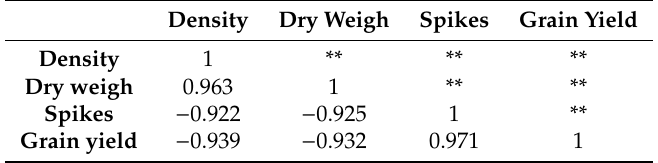
Table 3. Pearson’s correlation matrix for G. coronaria traits (density in plants m − 2 , average plant dry weigh in g m − 2 ) and wheat yield components (spikes density in number m − 2 , grain yield in g m − 2 ).